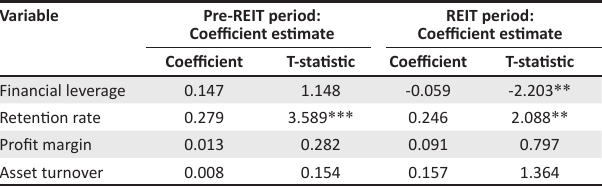
TABLE 5: Regression results for Tobin Q for the pre-real estate investment trust and real estate investment trust periods. Variable Pre-REIT period: REIT period: Coefficient estimate Coefficient